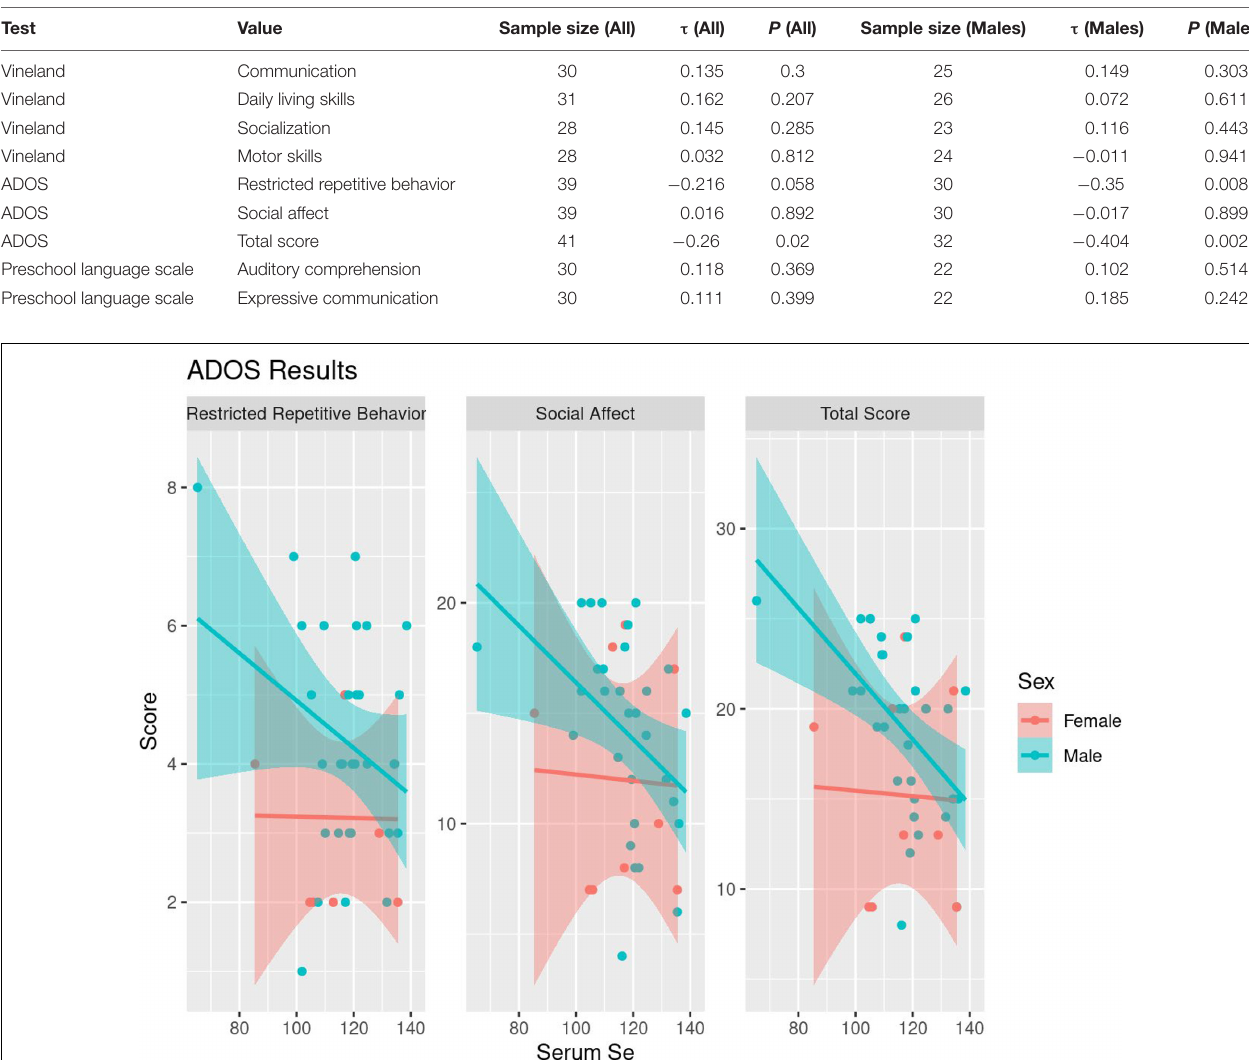
TABLE 5 | Tau rank correlations between various psychometric test scores and serum Se levels, in all patients and males only. Test